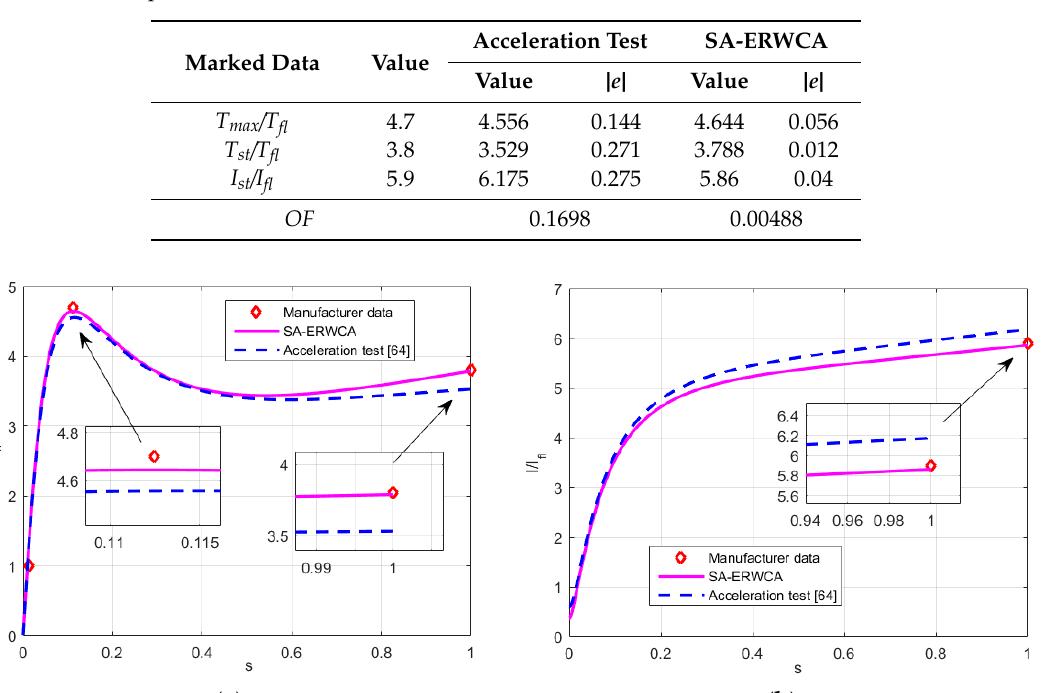
Table 16. Comparison of acceleration test and SA-ERWCA results with manufacturer data for Machine 3.